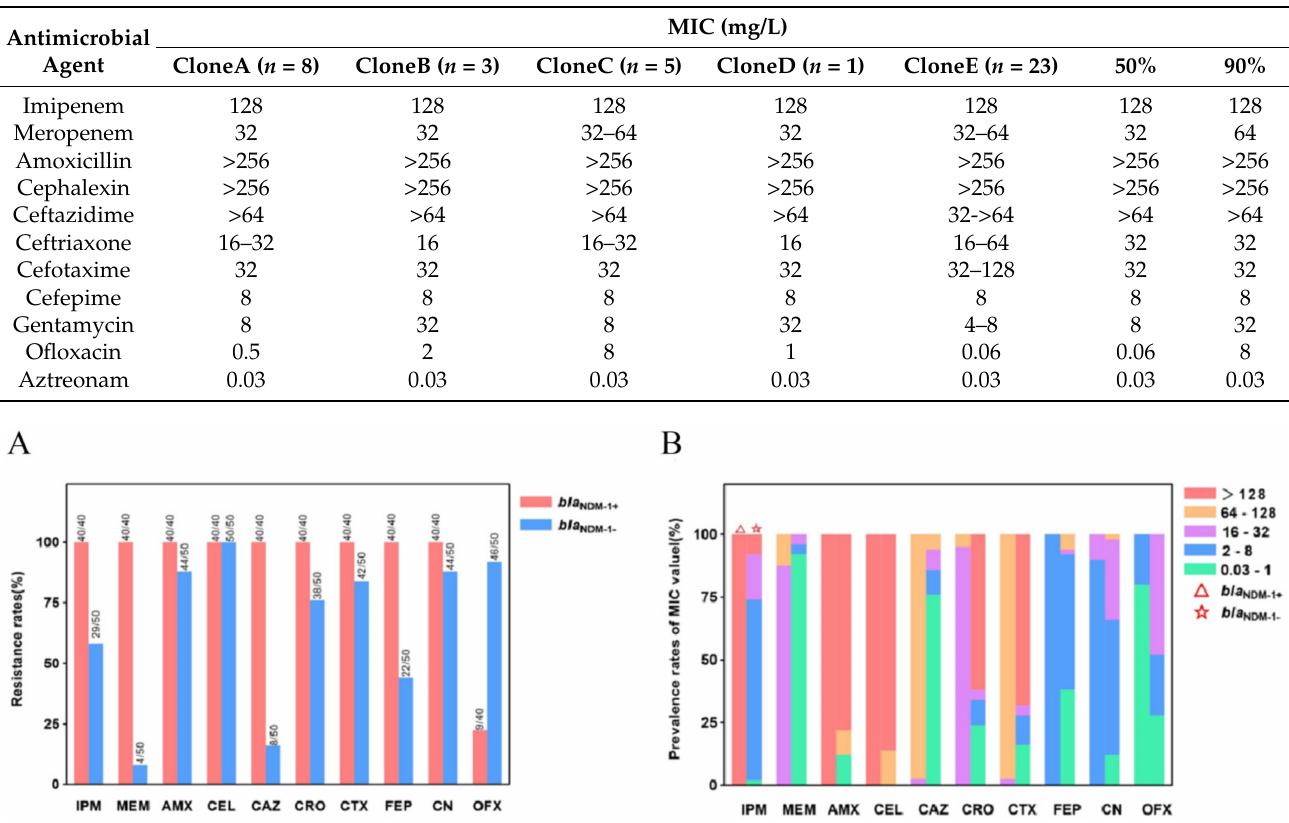
Figure 2. Detection of bla NDM-1 -positive ( n = 40) and bla NDM-1 -negative ( n = 50) P. mirabilis. ( A ) Agar dilution method of antimicrobial susceptibility test to detect the resistance rates of 10 common antibiotics of bla NDM-1 -positive and -negative strains. ( B ) Proportion of bla NDM-1 -positive and -negative strains to 10 common antibiotics’ MIC distribution